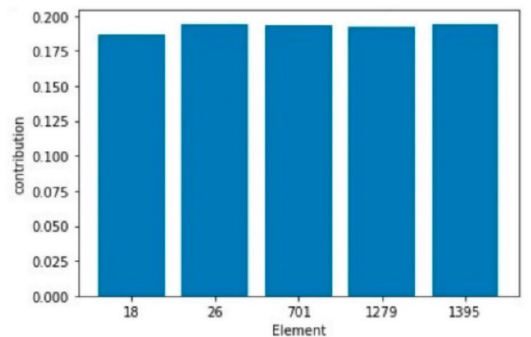
Figure 7. Feature contribution.